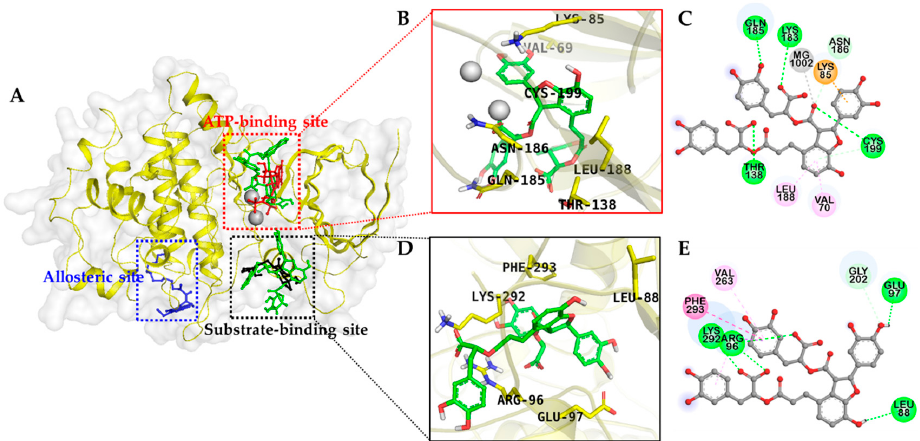
Figure 4. ( A ) Molecular docking of GSK-3 β binding with salvianolic acid B and with positive controls. The chemical structures of phosphoaminophosphonic acid-adenylate ester (AMP-PNP), andrographolide, VP0.7, and salvianolic acid B are shown using red, black, blue, and green colored sticks, respectively. Magnesium ions are shown as gray spheres. Amino acid residues of enzyme are shown in yellow sticks. ( B – E ) Closer views of the salvianolic acid B binding pose in ( B , C ), the ATP binding site and ( D , E ) is the substrate binding site.